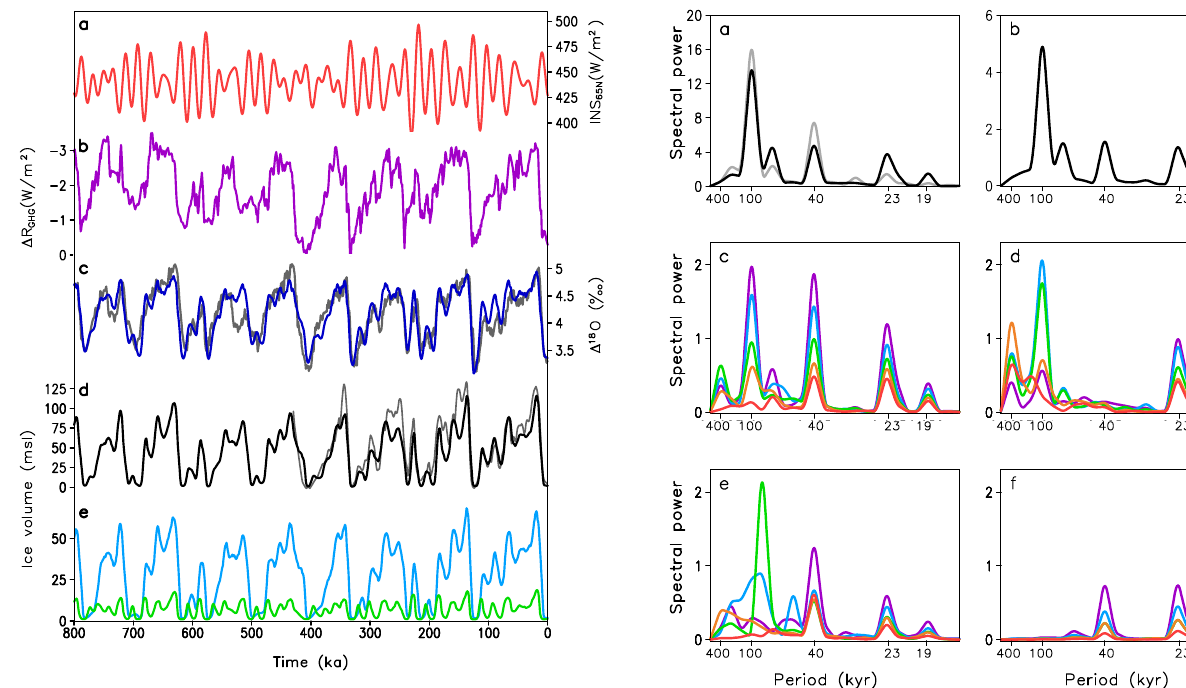
Fig. 2. (a) Maximum summer insolation at 65 ◦ N; (b) radiative forcing of prescribed equivalent CO 2 concentration; (c) simulated (blue) versus reconstructed (grey) benthic δ 18 O c stack (Lisiecki and Raymo, 2005), (d) simulated (black) versus reconstructed (grey) global sea level change (Waelbroeck et al., 2002); (e) simulated North American (blue) and European (green) ice volume in meters of sea level (m.s.l.).